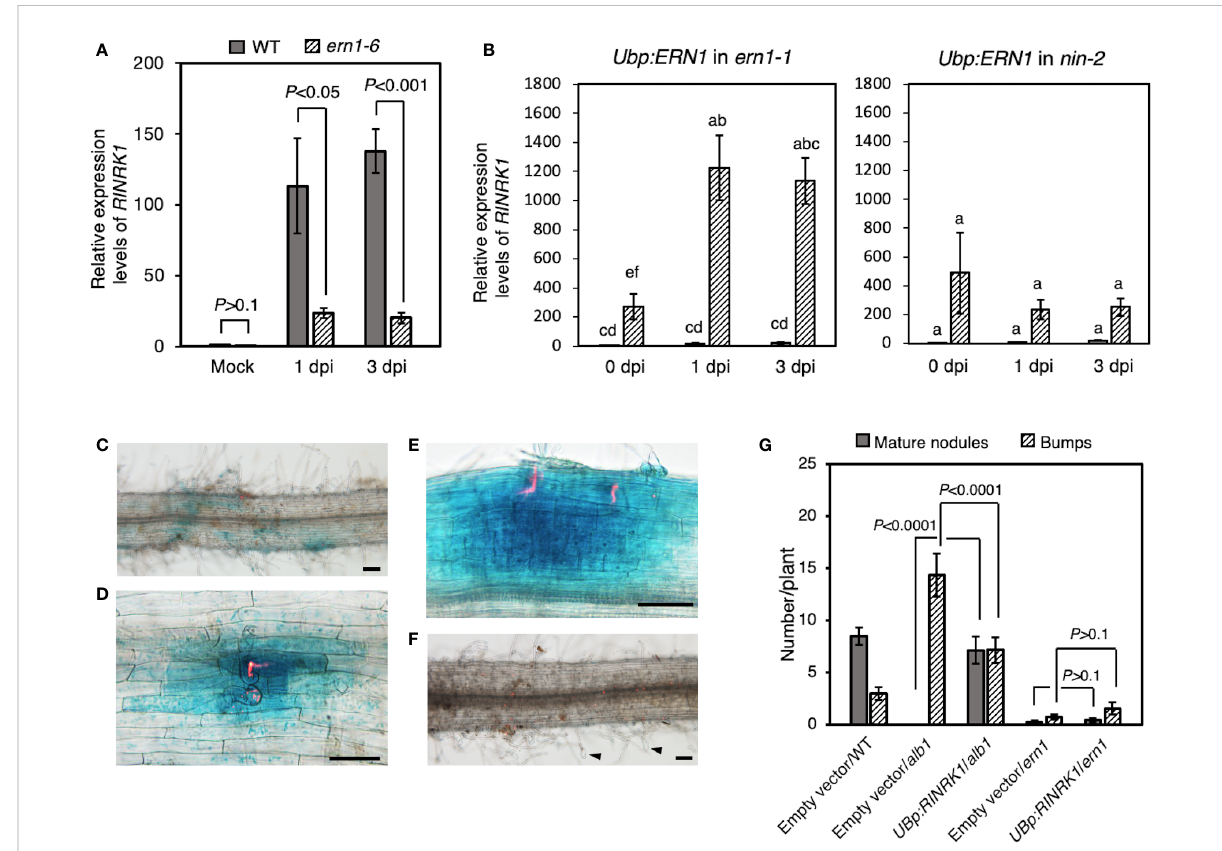
FIGURE 4 Positive regulation of RINRK1 by ERN1. (A) Relative expression levels of RINRK1 in WT and Ljern1-6. (B) Relative expression levels of RINRK1 in Ljern1-1 and Ljnin-2. Roots transformed with an empty vector (gray bar) or UBp : ERN1 (stripe bar). Data are means of fold changes normalized to Ubiquitin and displayed relative to the empty vector control of Ljern1-1 at 0 dpi (non-inoculation). Error bars indicate SE (n = 3, sample size = 12 plants). Statistical analysis was performed by ANOVA followed by Tukey's HSD test (P<0.05). GUS expression from RINRK promoter after inoculation with DsRed-labeled M. loti . Roots of WT (C – E) or the Ljern1-6 mutants (F) . Scale bars, 200 m m. Arrow heads: balloon-shaped root hairs. (G) Effects of overexpression of RINRK1 on nodulation in the hairy roots of the alb1 and Ljern1-1